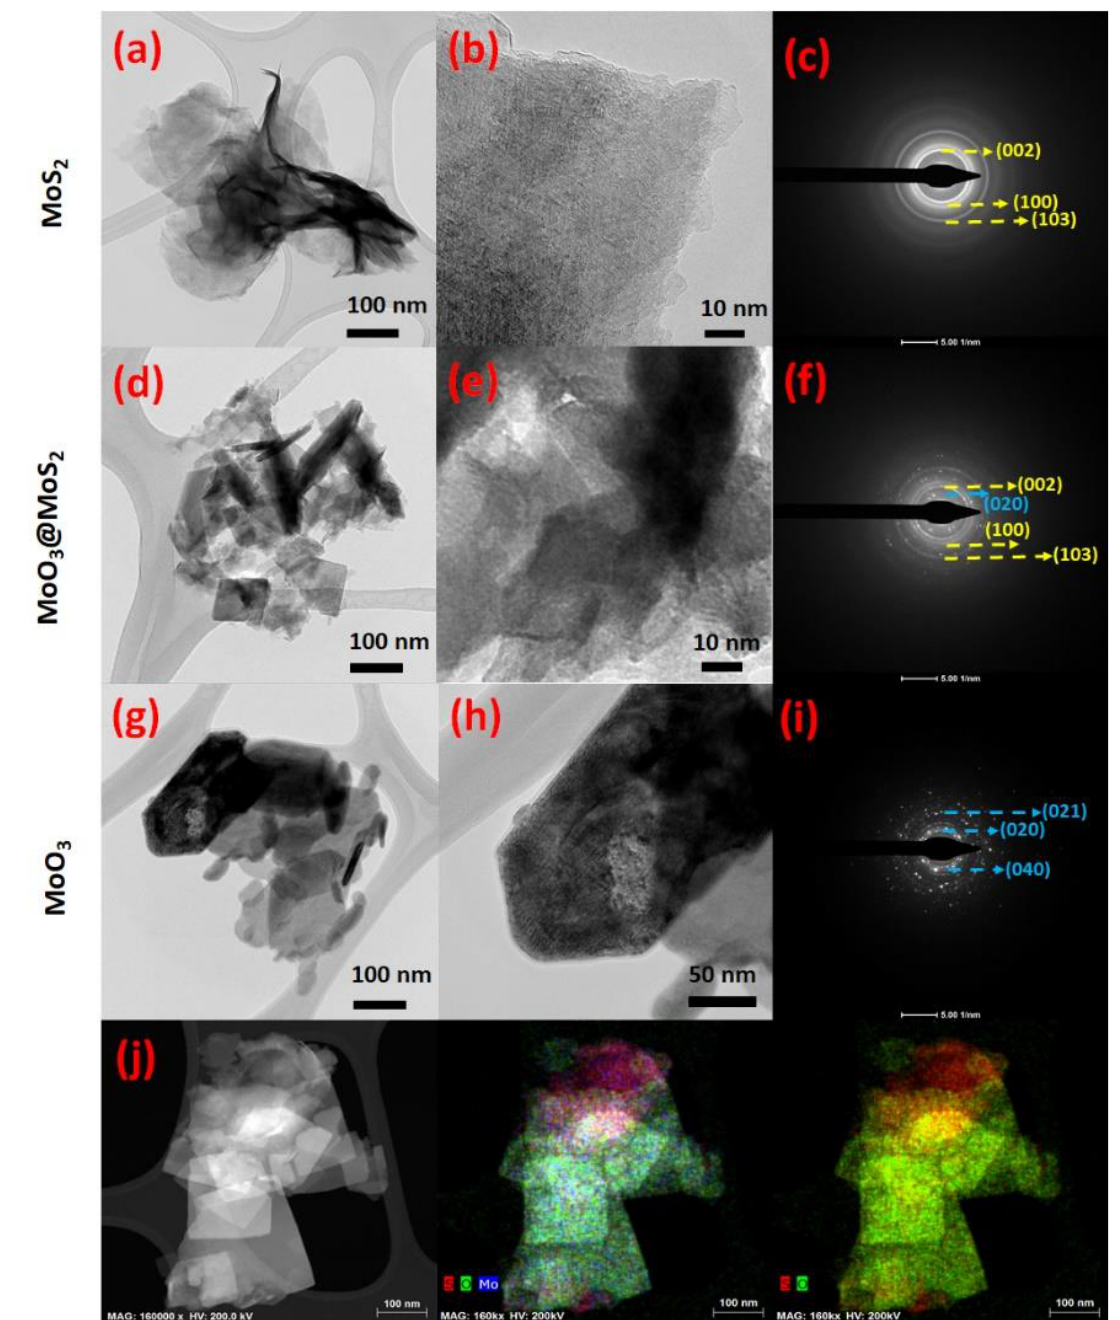
Figure 5. TEM images and corresponding SAED pattern of ( a – c ) MoS 2 , ( d – f ) MoO 3 @MoS 2 , ( g – i ) MoO 3 . ( j ) TEM-EDS mapping image of MoO 3 @MoS 2 . The electrochemical performance of each sample was tested in the LIB half-cells. The cyclic voltammetry (CV) of the MoO 3 @MoS 2 hybrid was measured in the voltage window of 0.01 to 3.0 V with a sweep speed of 0.1 mV s − 1 ; the result is shown in Figure 6a. A